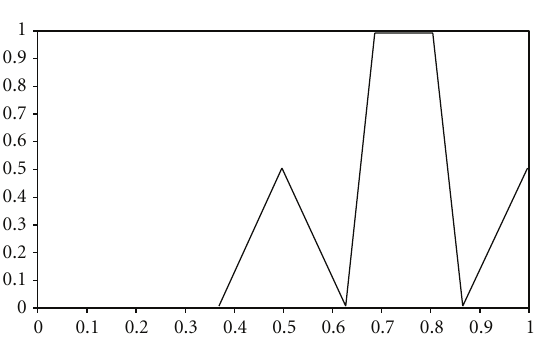
Figure 7: Output result for employee’s knowledge